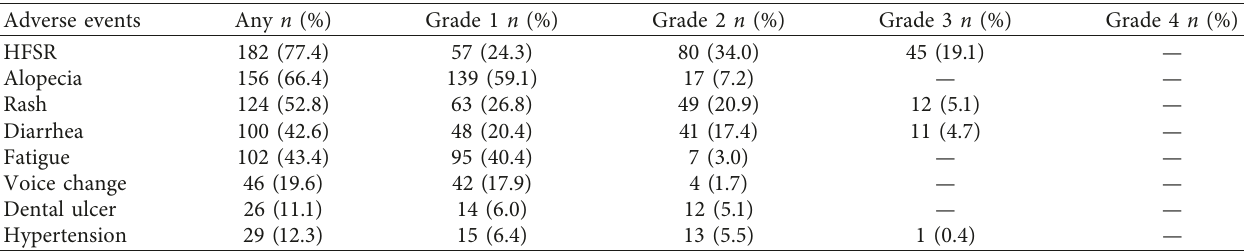
Table 2: Number (percentage) of patients reporting nonlaboratory sorafenib related adverse events by CTCAE grading. Adverse events